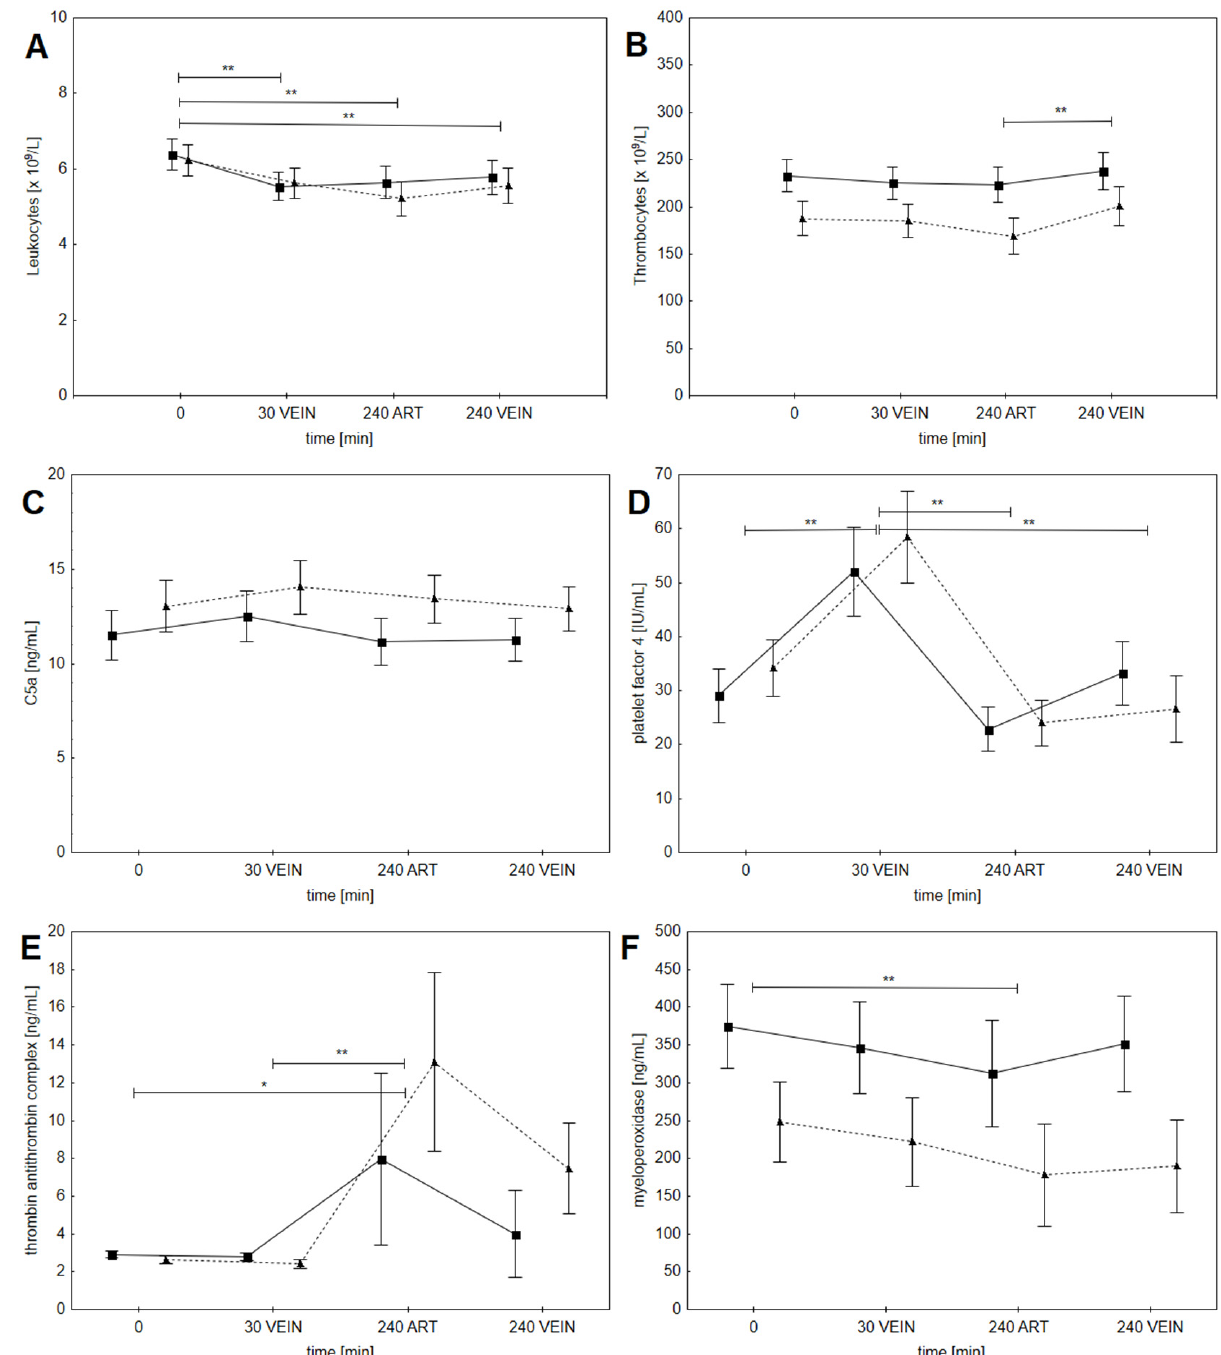
Figure 2. Results of repeated measures ANOVA for different biocompatibility parameters: ( A ) Leukocytes, ( B ) Thrombocytes, ( C ) complement fraction C5a, ( D ) platelet factor 4, ( E ) thrombin-antithrombin complex and ( F ) myeloperoxidase. The values shown are least-square estimates with standard error. The standard dose group is shown with squares and full line and the increased dose group with triangles and dashed line. When there was a significant effect of time, different time points were compared with a Bonferroni post-hoc test (* p < 0.05 and ** p < 0.01). There was no effect of dose group or interaction effect in any of the measured parameters.